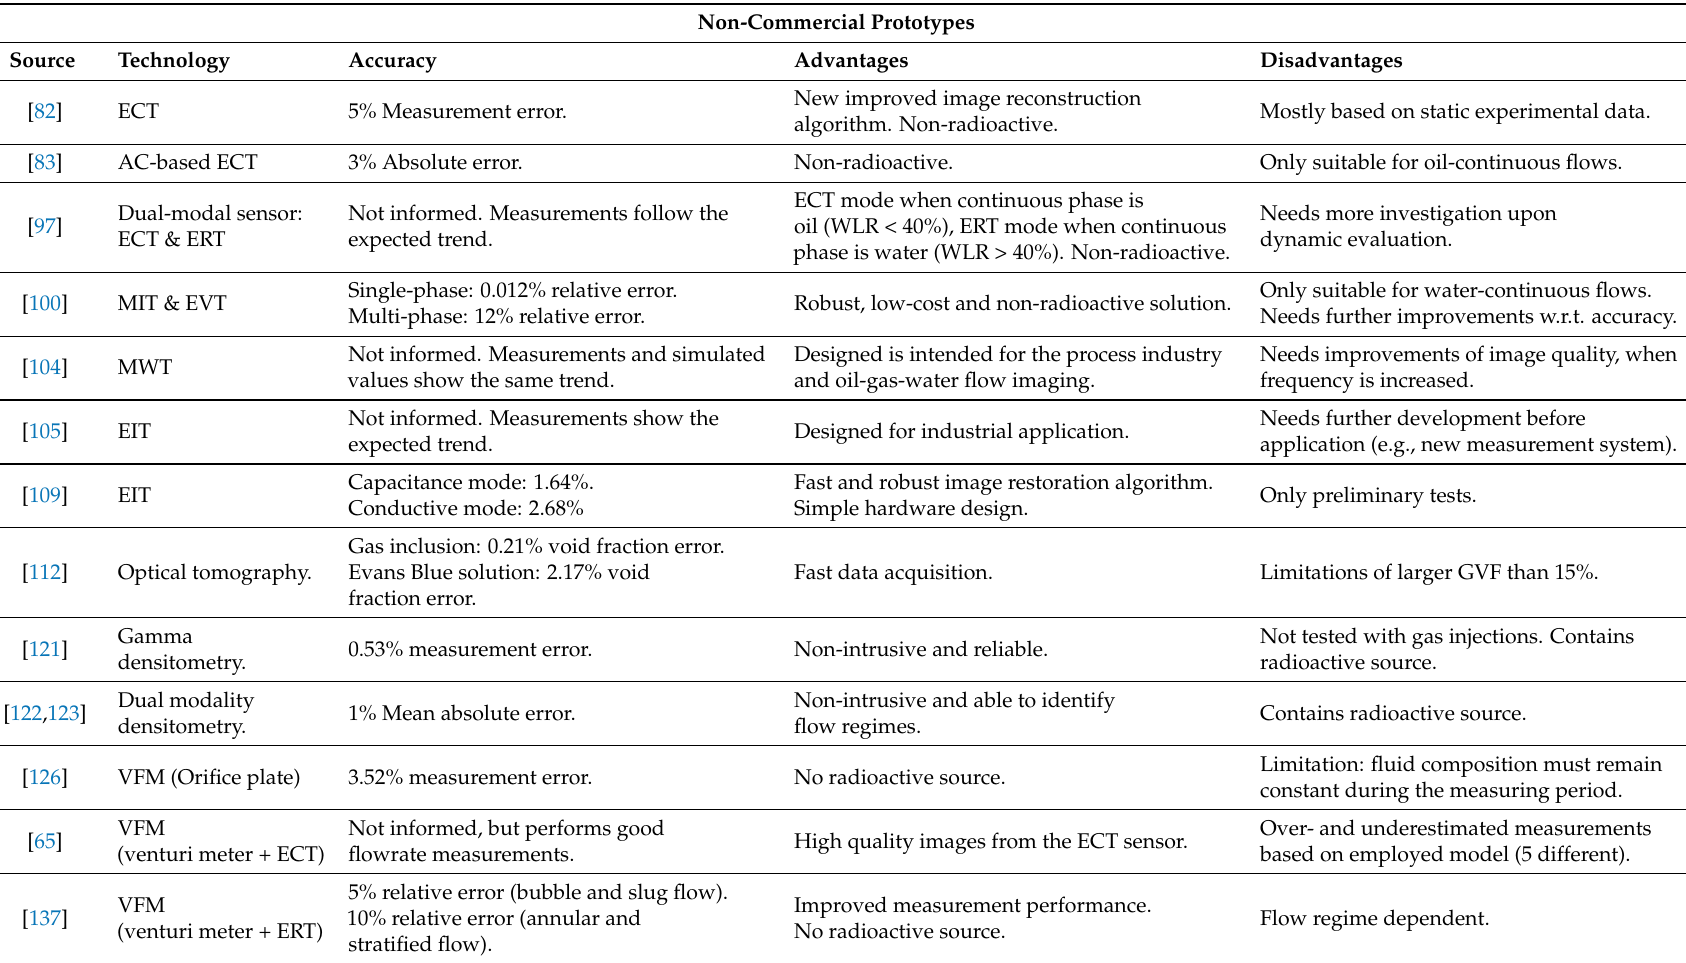
Table 1. List of current non-commercial prototypes to monitor multi-phase